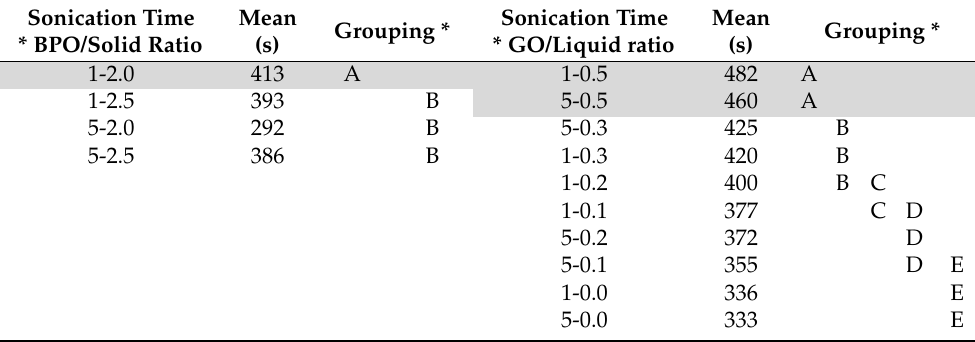
Table 3. Grouping information for t set using Tukey’s test and 95%